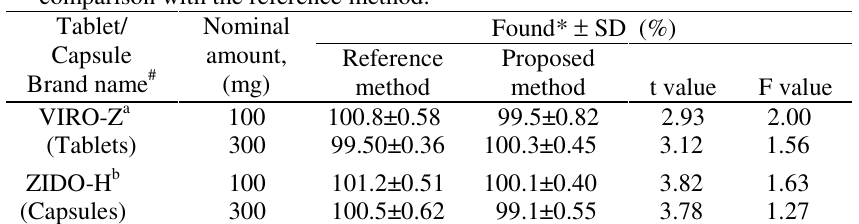
Table 3 . Results of determination of zidovudine in formulations and statistical comparison with the reference